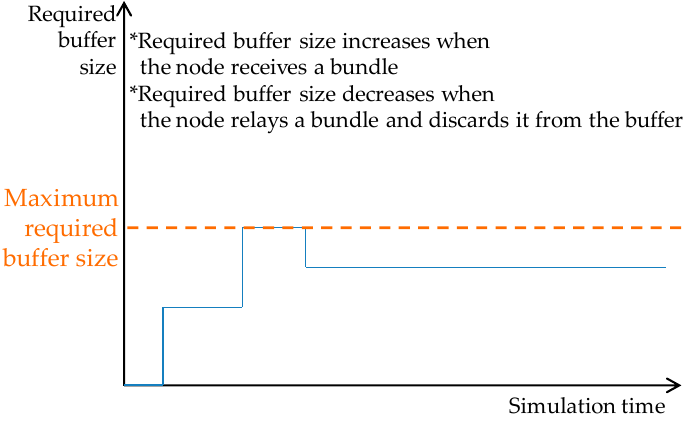
Figure 26. How the required buffer size of a node varies over time.